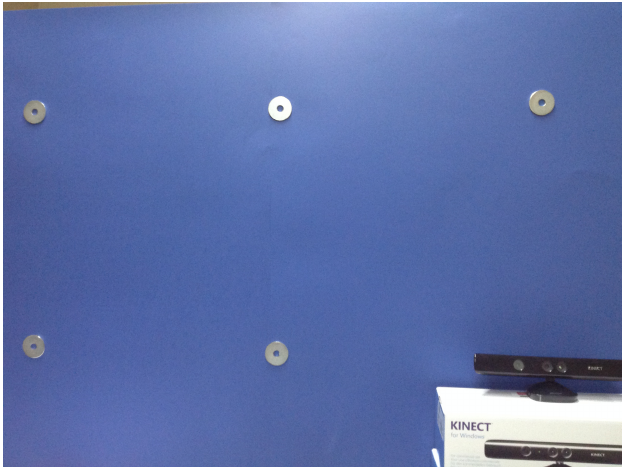
Figure 5. A portion of the panel used in the experimental phase.